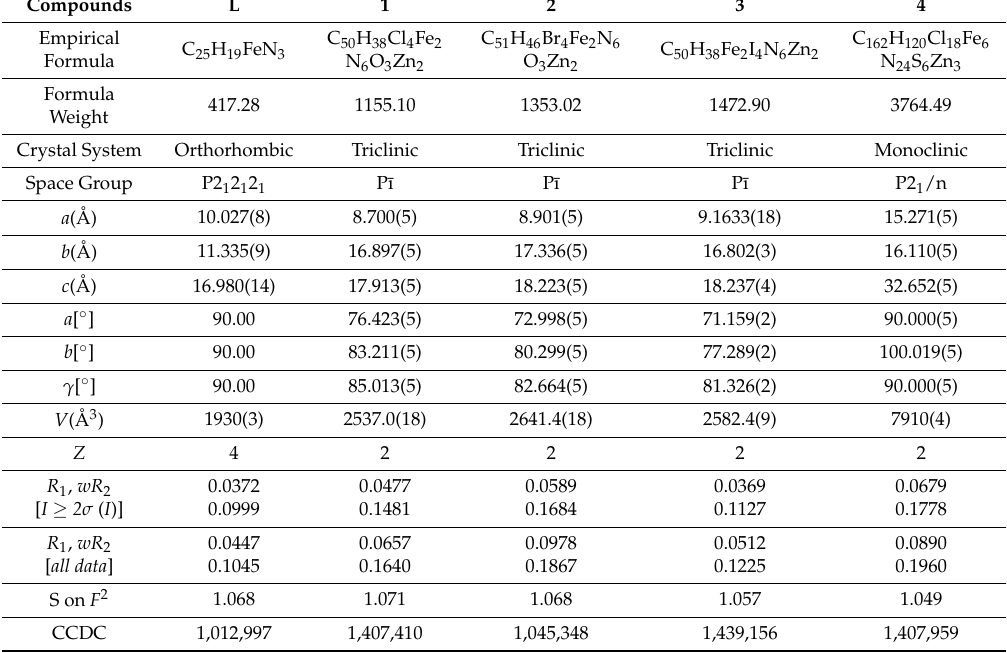
Table 1. Crystallographic data and structural refinement parameters for L and complexes 1 – 4